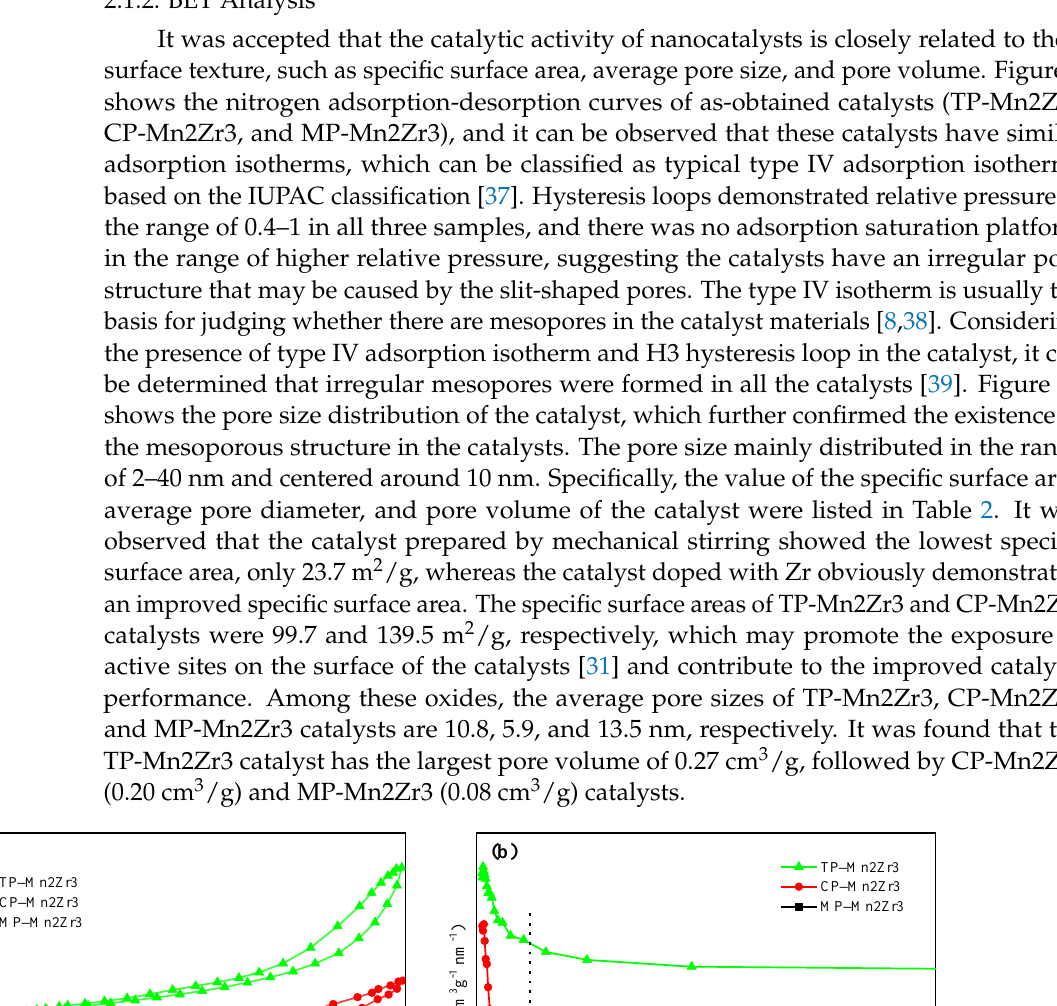
Figure 2. Nitrogen adsorption-desorption isotherms ( a ) and BJH pore-size distributions ( b ) of TP-Mn2Zr3, CP-Mn2Zr3, and MP-Mn2Zr3 catalysts.